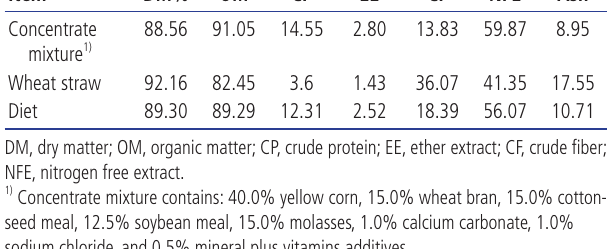
Table 1. Chemical composition of ingredients and diet used in experiment 1 and 2 (on DM basis, %)